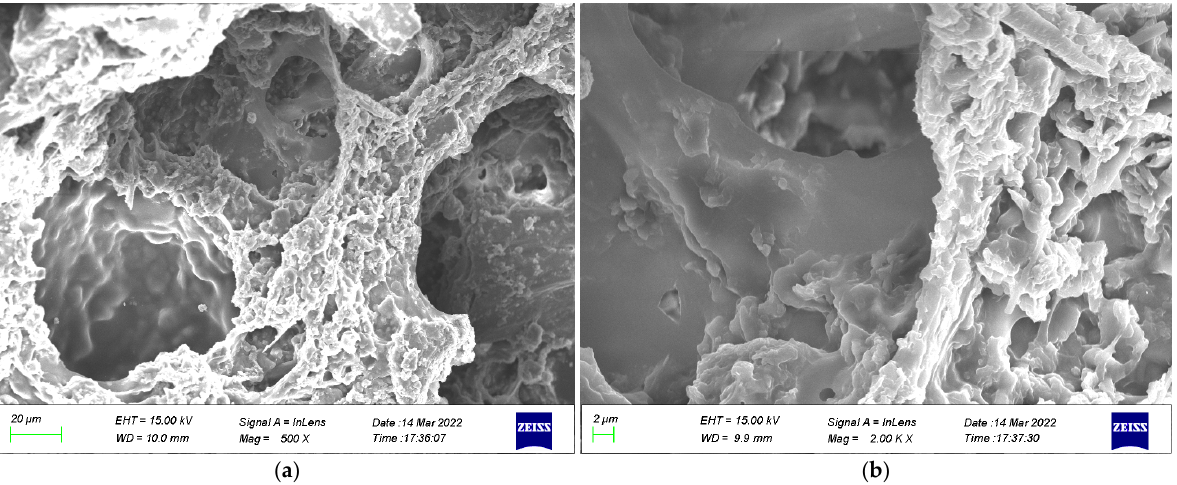
Figure 19. Micro-structure of aggregate, WER content 15%: ( a ) 500×; ( b ) 2000×.